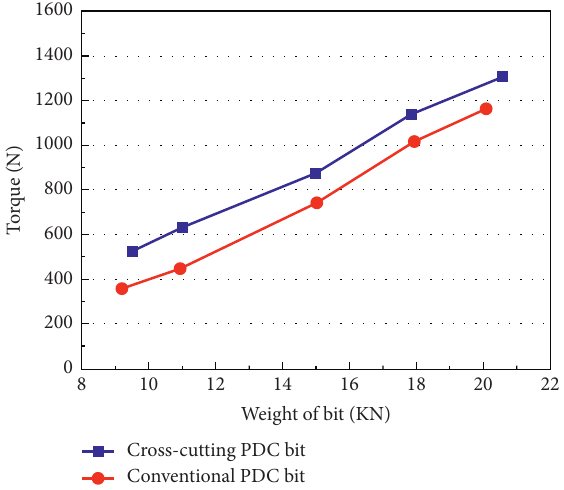
Figure 25: Relationship between WOB and torque during drilling